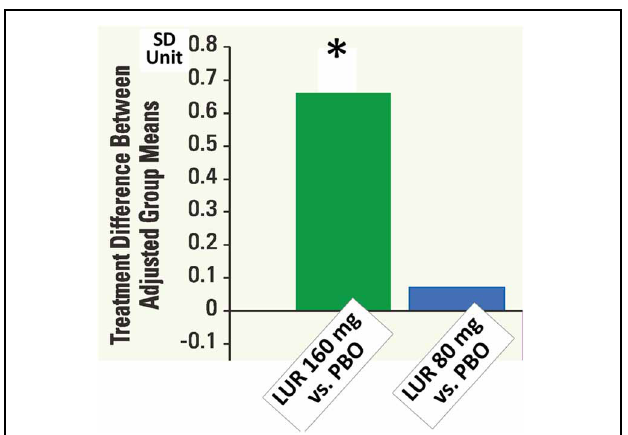
FIGURE 9 | Cognitive composite z-scores in double-blind 6-week acute phase study of lurasidone (LUR) relative to placebo (PBO). Data are based on LOCF analysis of CogState composite score (standardized z-score) at week 6 in the evaluable-test sample set ( N = 267). ∗ P < 0 . 05, ANCOVA adjusted for baseline and pooled